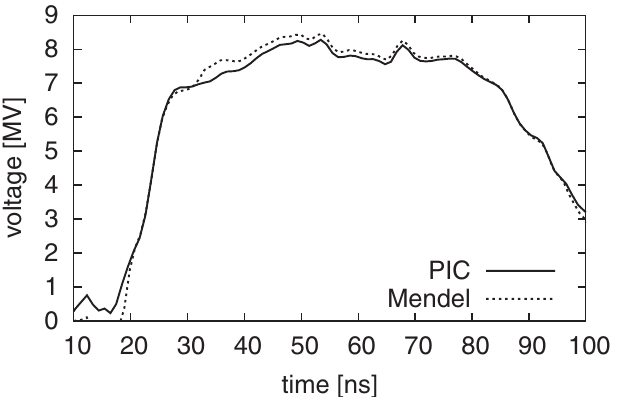
FIG. 4. Simulated transmission-line voltage at position G com- pared to Mendel’s pressure balance theory (using simulation currents) for a large area diode with a 10.3 cm A-K gap on the straight transmission line of Fig.